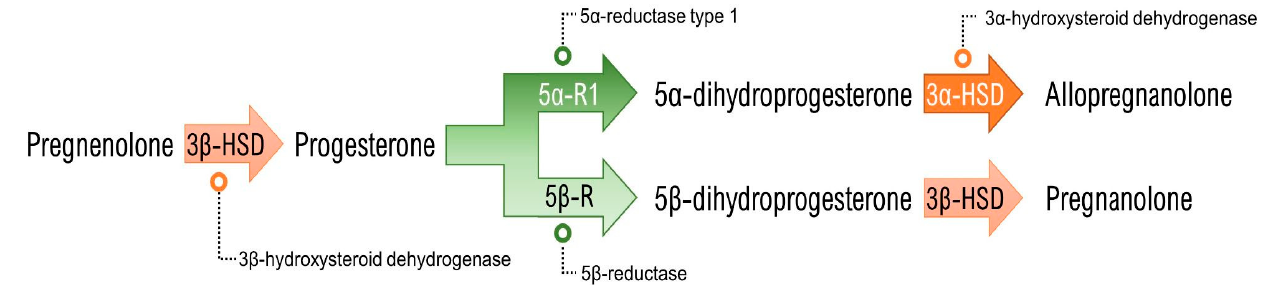
Figure 1. Allopregnanolone (and its isomer pregnanolone) synthesis pathway from pregnenolone. Allopregnanolone and pregnanolone are capable of modulating neuronal activity, specifically potentiating GABAergic neurotransmission due to their potent, positive and allosteric modulation of the action of GABA at GABA A Rs. Importantly, pretreatment with allopregnanolone attenuates the endocrine response to stress [36,37], probably ow- ing the GABA-mediated inhibition of CRH neurons. This appears to occur following tonic activation of extrasynaptic GABA A Rs containing the δ subunit, which makes them particularly sensitive to neurosteroids [38]. Additionally, allopregnanolone acts through genomic pathways, downregulating the gene expression of CRH [36] and of AVP [37] in the hypothalamus of rats. These findings place allopregnanolone as an important neuromodu- lator involved in the regulation of stress response and as part of the allostatic mechanisms exerting a negative feedback on the HPA axis (Figure